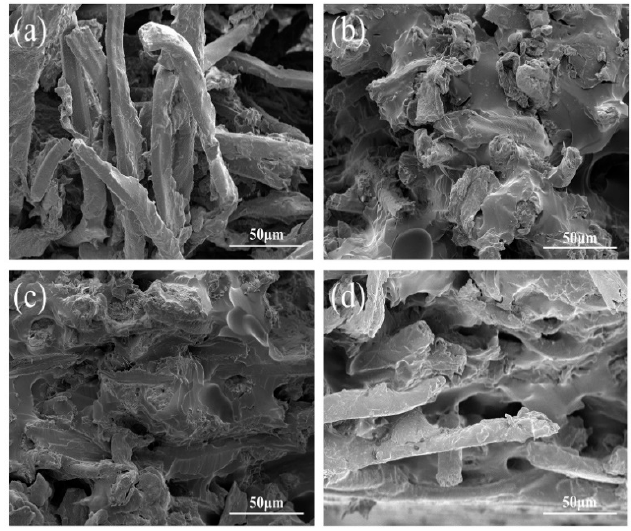
Figure 7. SEM images of cross section morphology of ( a ) SEC1.2/20, ( b ) SEC1.2/40, ( c ) SEC1.2/50, and ( d ) SEC1.5/50.